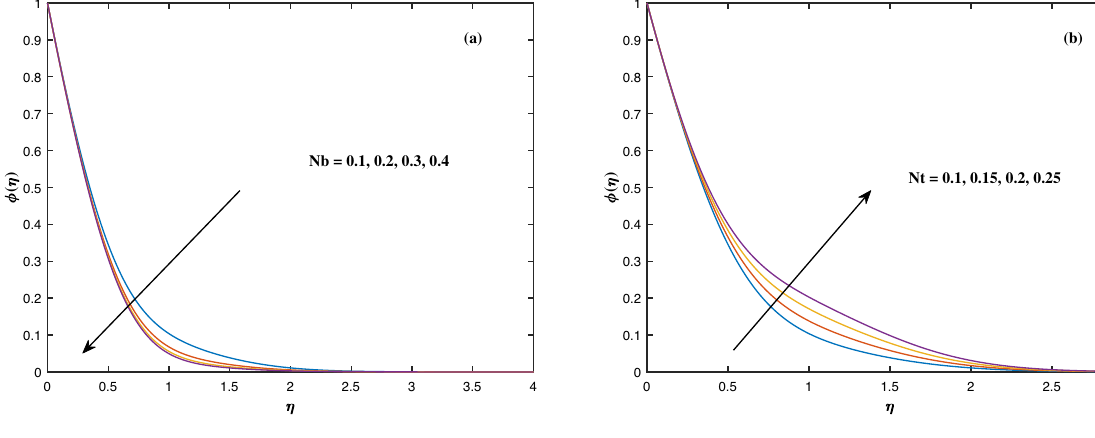
Figure 8. Fluctuation in φ(η) with ( a ) Nb and ( b ) Nt .